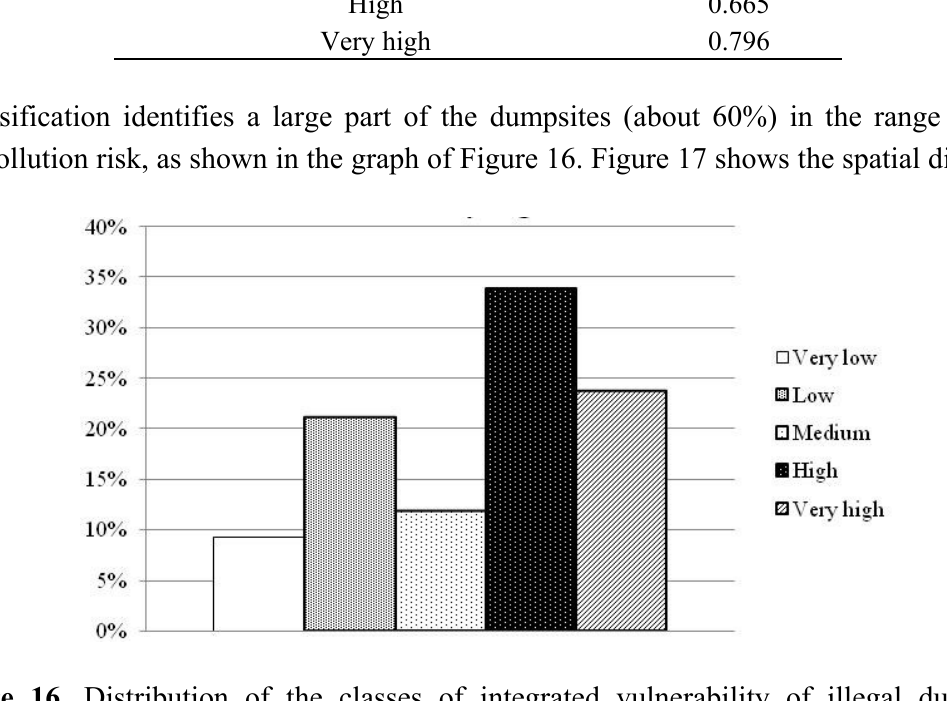
Figure 16. Distribution of the classes of integrated vulnerability of illegal dumpsite (fuzzy logic